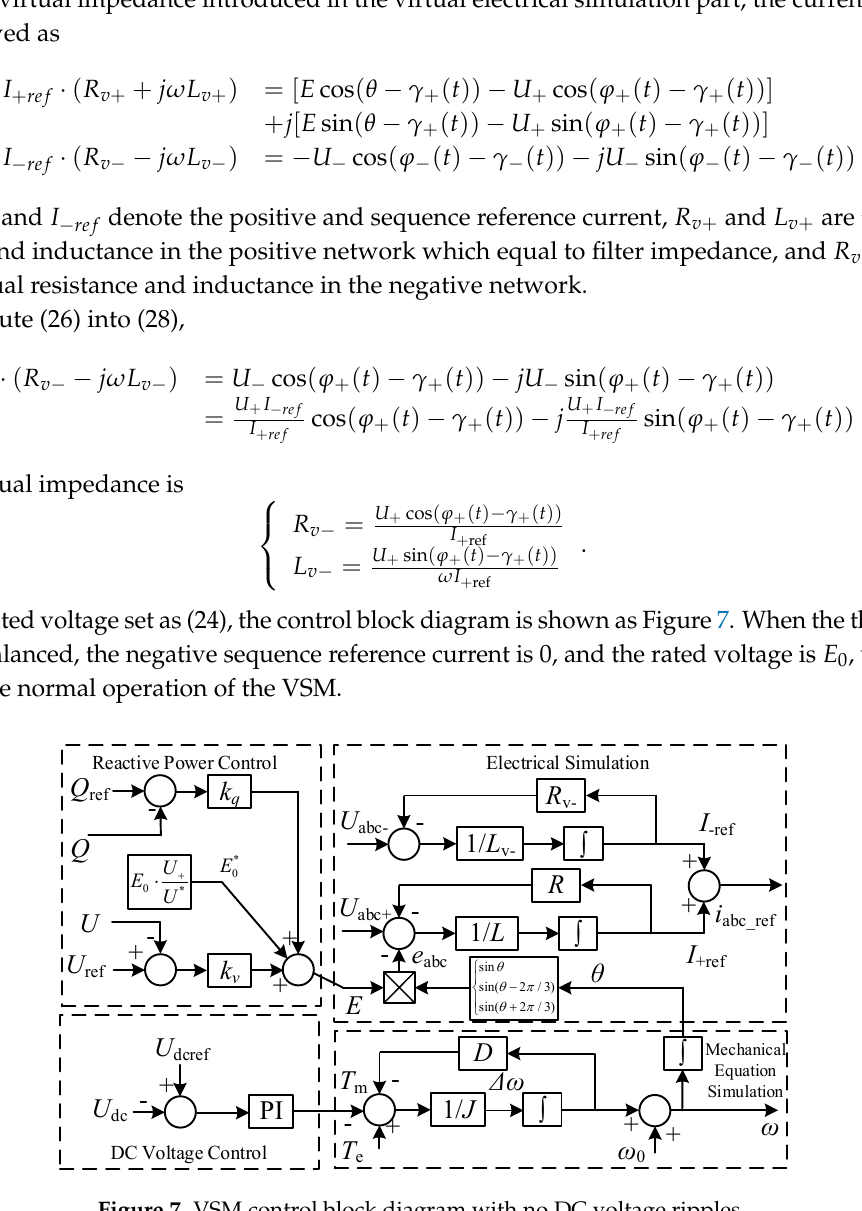
Figure 7. VSM control block diagram with no DC voltage ripples.